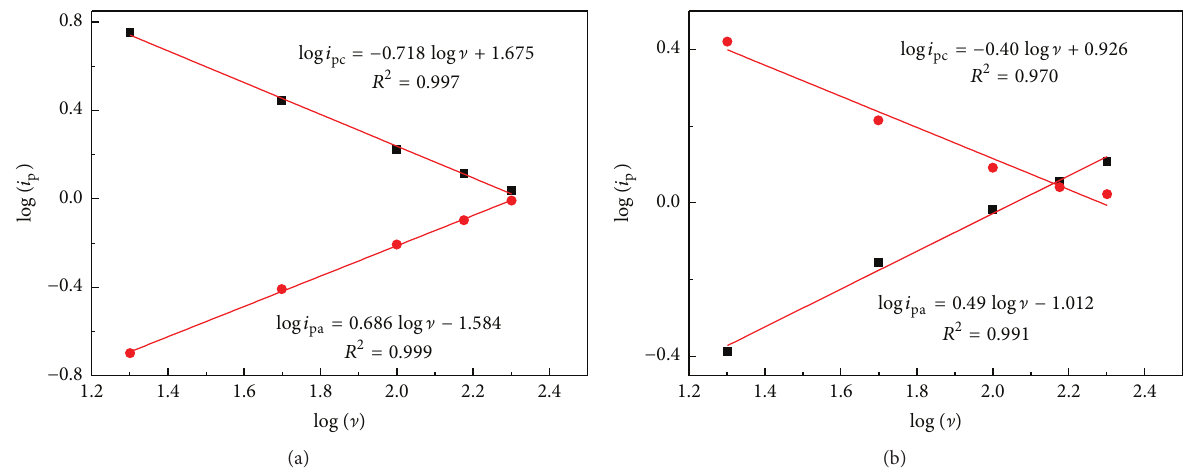
Figure 6: Plot of log 𝑖 p versus log scan rate for (a) PPy-IC and (b) PPy-IC-Ag nanop films.